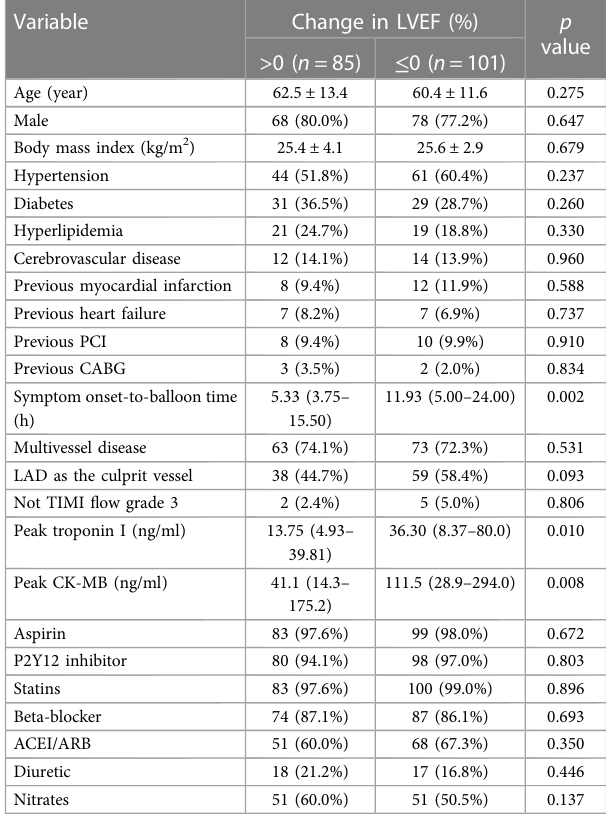
TABLE 2 Baseline and follow-up echocardiographic parameters. Parameter